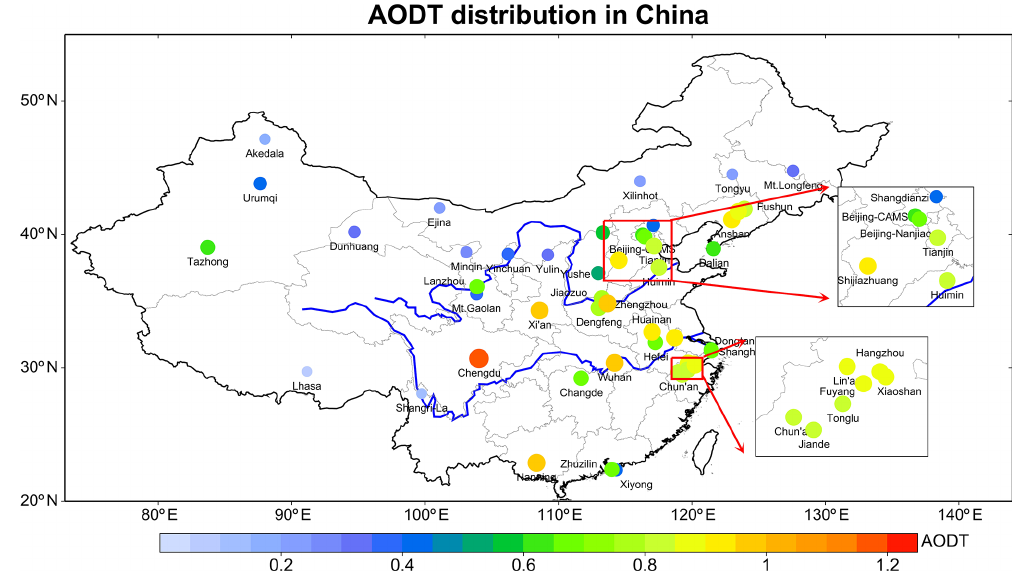
Figure 2. Annual spatial distribution of aerosol optical depth (AOD) at 440nm at the CARSNET sites.